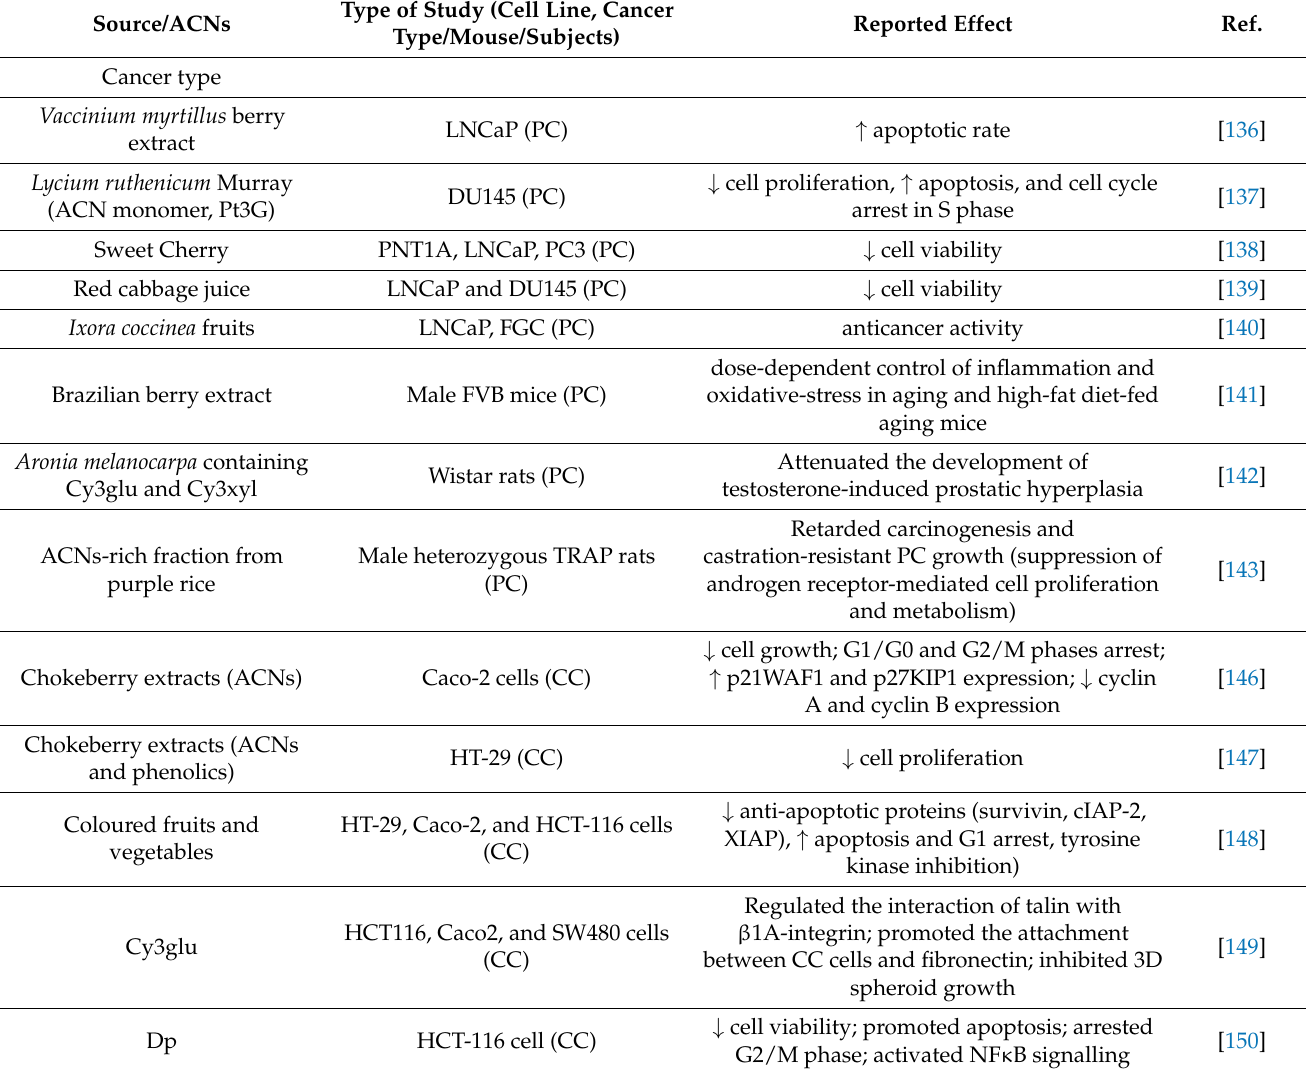
Table 4. The effects of ACNs in different forms of